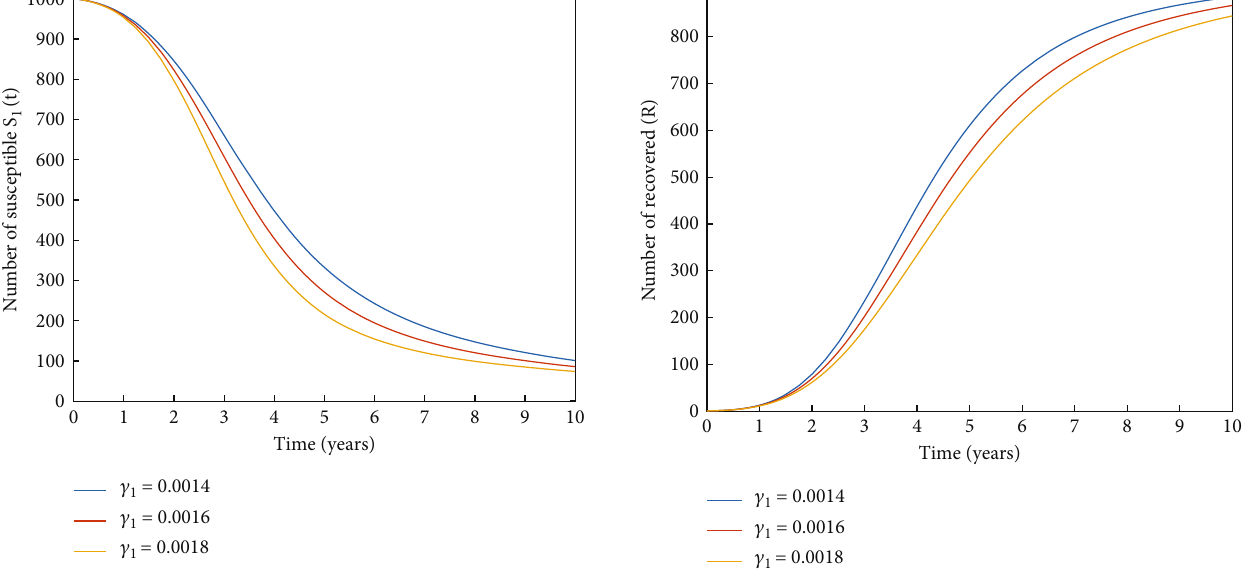
Figure 23: Transformation of susceptible individuals for transmission rate γ 1 with various values.